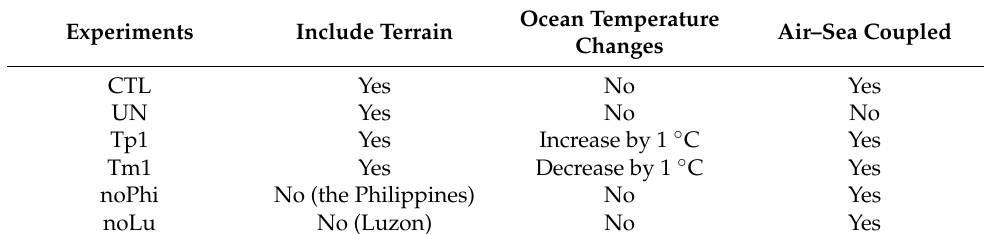
Table 2. Numerical experiments for Supertyphoons Mangkhut and Yutu approaching the north- ern Philippines.